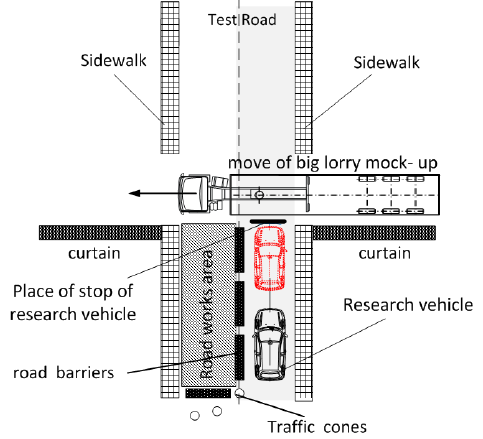
Fig. 4. Diagram of ‘Scenario 3’